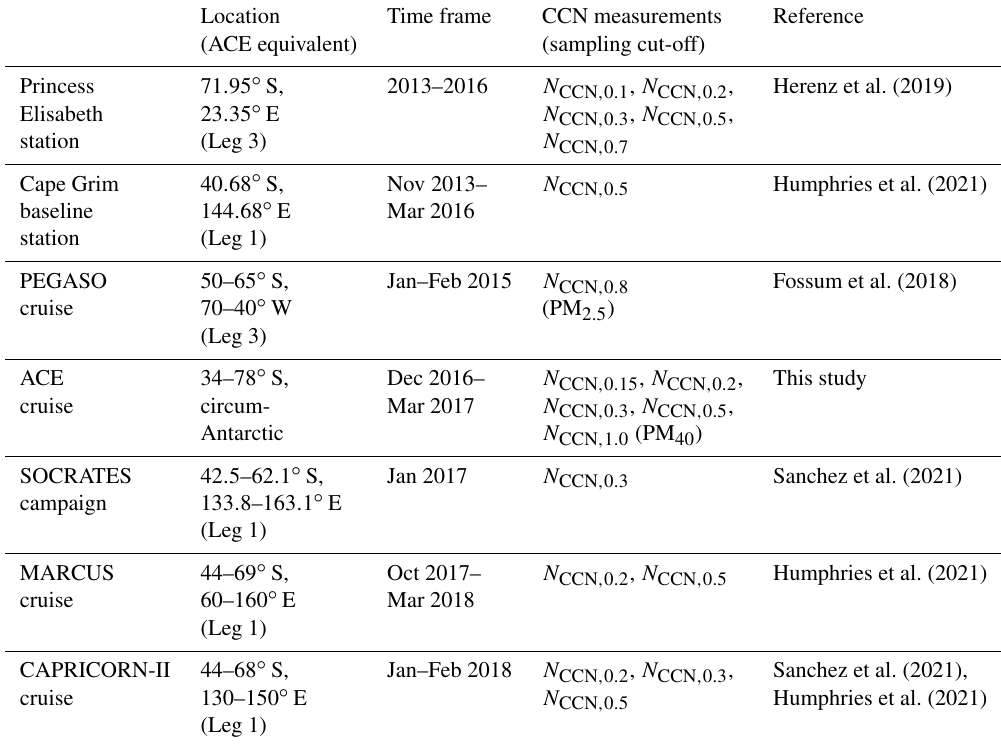
Table 1. Overview of a selection of studies on aerosol particles and CCN over the summertime Southern